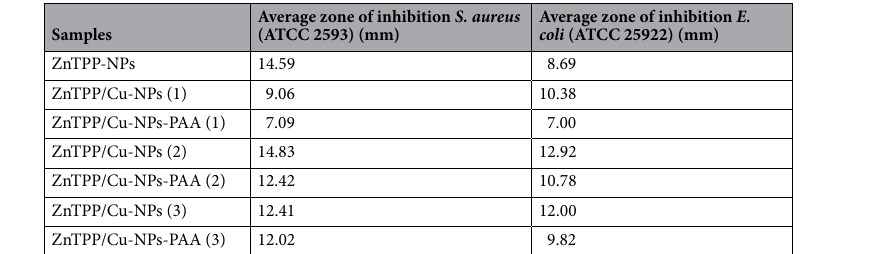
Table 2. Average zone of inhibition of samples.